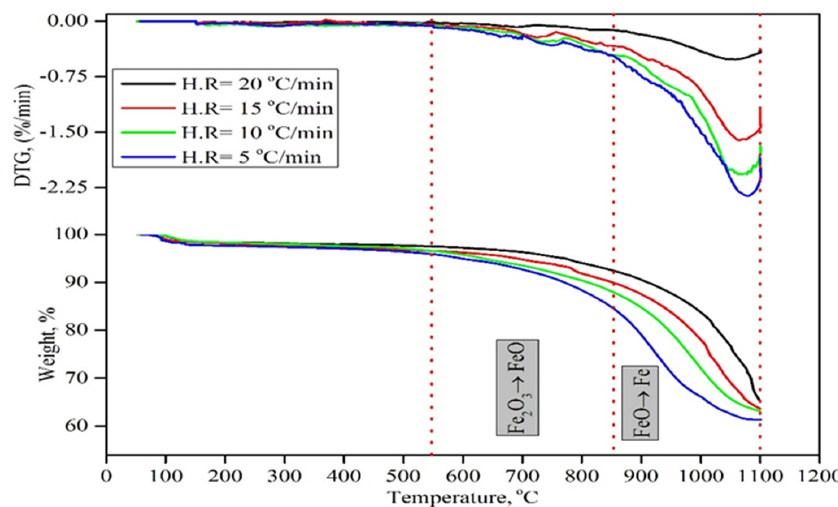
Figure 7. Influence of reduction temperature on the TG and DTG of the iron ore fines–charcoal composites using different heating rates (H.R).